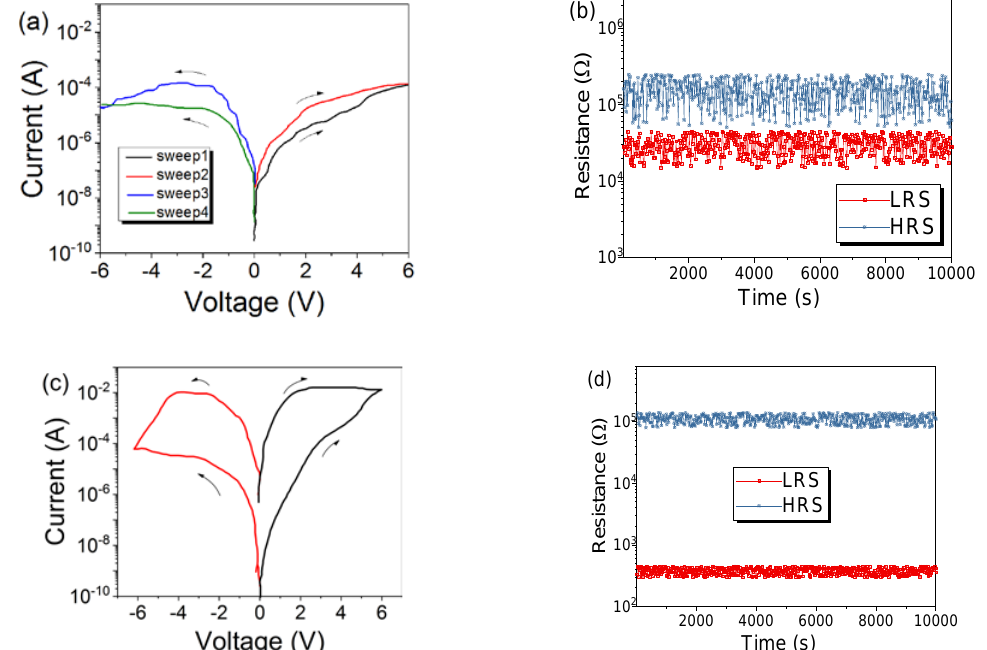
Figure 5. ( a ) I–V curves of the Co–Al LDHs memristor at 158 ◦ C. ( b ) Data retention capability of Co–Al LDH memristor in HRS and LRS at − 2 V constant voltage under 158 ◦ C. ( c ) I–V curves of the Co–Al LDHs memristor at 85 ◦ C. ( d ) Data retention capability of the Co–Al LDHs memristor in HRS and LRS at − 2 V constant voltage under at 85 ◦